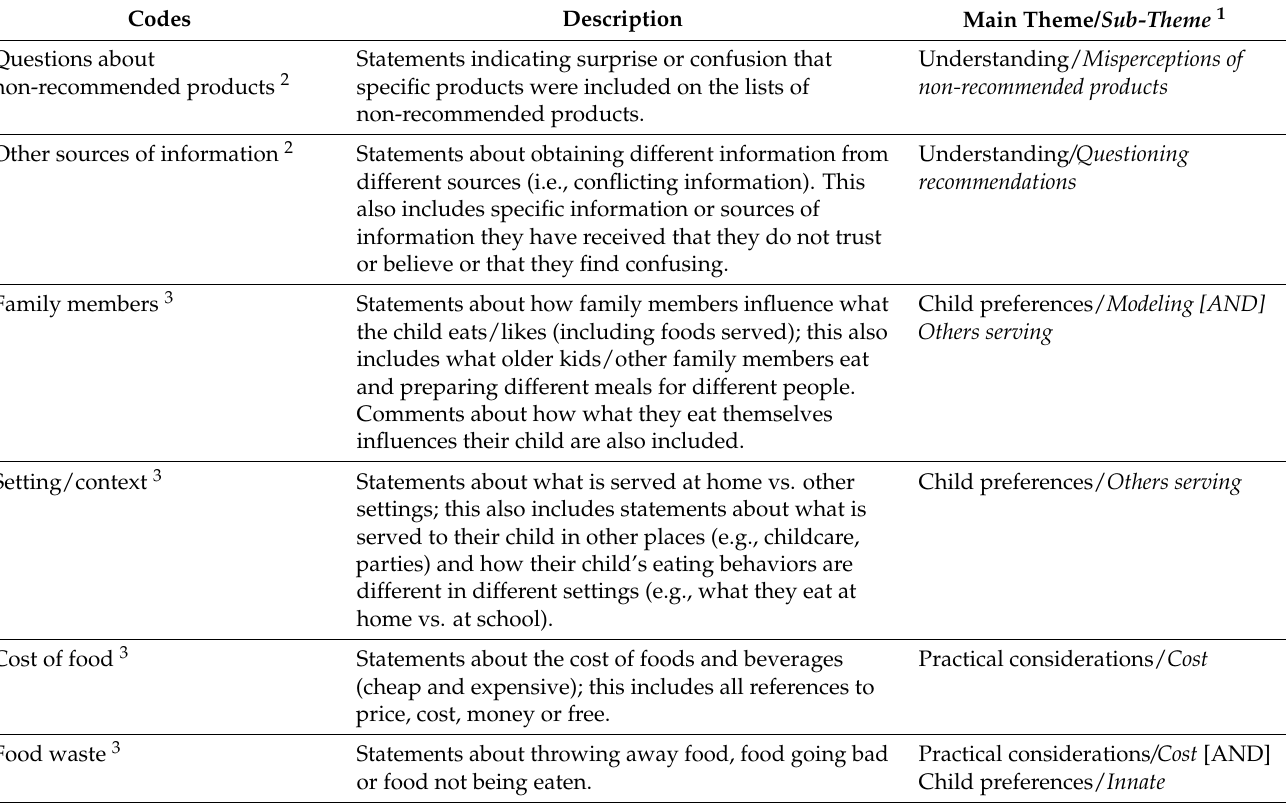
Table 1. Individual code definitions and the application to themes/sub-themes describing barriers to following expert